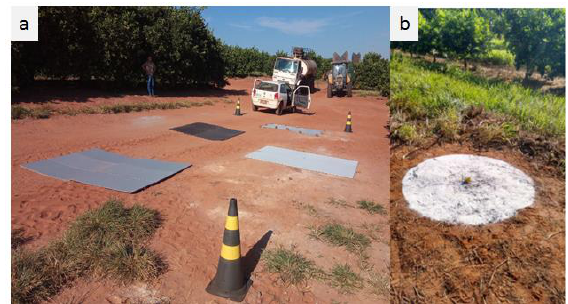
Figure 2. (a) Radiometric Targets. (b) Geometric Targets. During the images acquisition a spectrometer was used to gather radiometric measurements in the orange orchards to obtain the spectral curves of the healthy oranges and those infected with HLB. With the spectral curves measured in the field, a spectral library was constructed to serve as reference in the procedures of radiometric correction and images classification. Figure 3 shows examples of healthy orange and those infected with HLB.